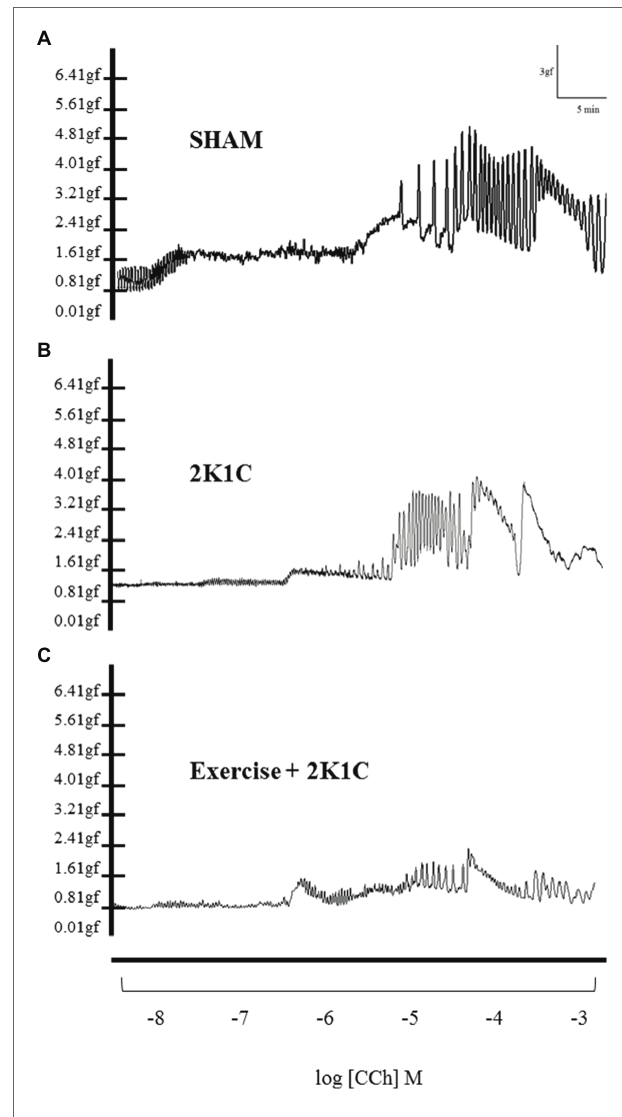
FIGURE 4 | Original traces of contraction of segments of duodenum as concentrations of carbachol (-8M to -3M in log) in Sham (A) , 2K1C (B) and 2K1C+Exercise (C)